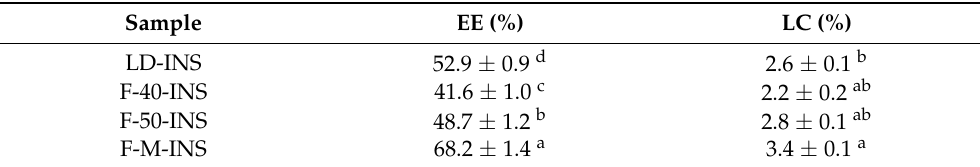
Table 2. Encapsulation efficiency and loading capacity of LD-INS, F-40-INS, F-50-INS, and F-M-INS inclusion